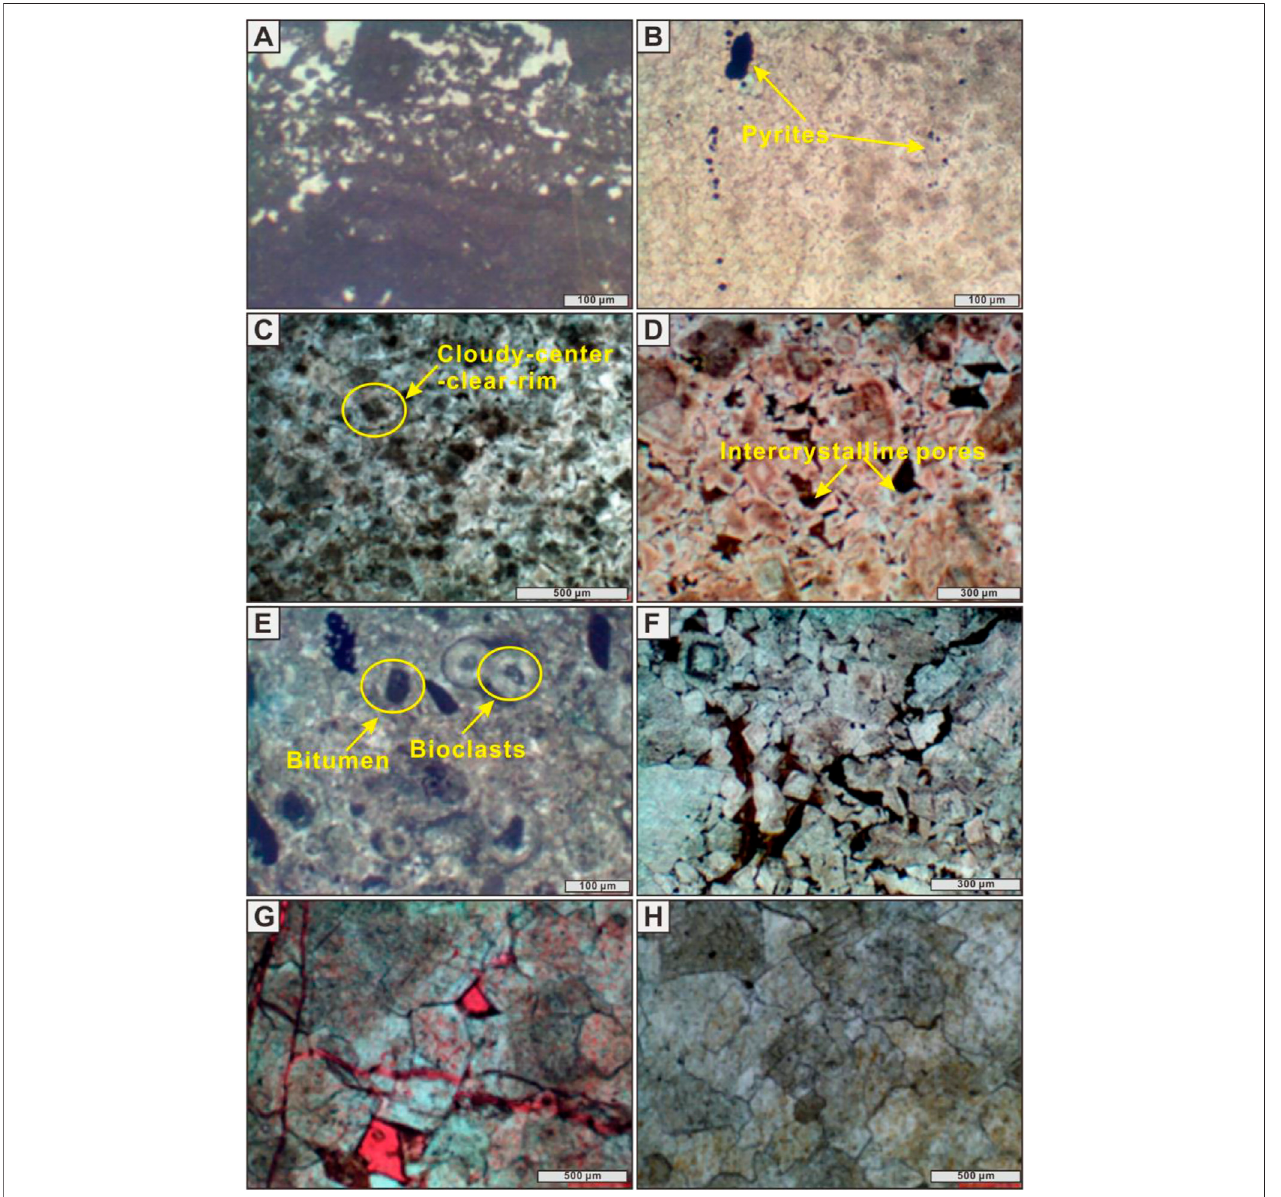
FIGURE 3 | Photomicrographs showing mineralogic features of dolostones in the studied interval under plane-polarized light. (A) Micritic dolomites showing anhedraltosubhedral crystalswithmicritic grain sizes.Well-J48, 3,225.86 m. (B) Pyrites distributed inmicriticdolomitesinscatter. Well-J432, 3,584.12 m (C) “ Cloudy- center-clear-rim ” features developing medium-sized dolomite. Well-J48, 3,237.48 m. (D) Intercrystalline pores developing in medium-sized dolomites. Well-J48, 3,239.89 m. (E) Bitumen and bioclasts developing in microbialites. Well-J445, 4,105.56 m. (F) Residual pores are visible in medium-sized dolomites of microbialites. Well-J431, 4,425.11 m. (G) Dolomite cements developing intercrystalline pores. Well-J431, 4,428.91 m. (H) Dolomite cements composed of smaller crystals developing no porosities and exhibiting saddle shapes. Well-J52, 4,123.56 m.